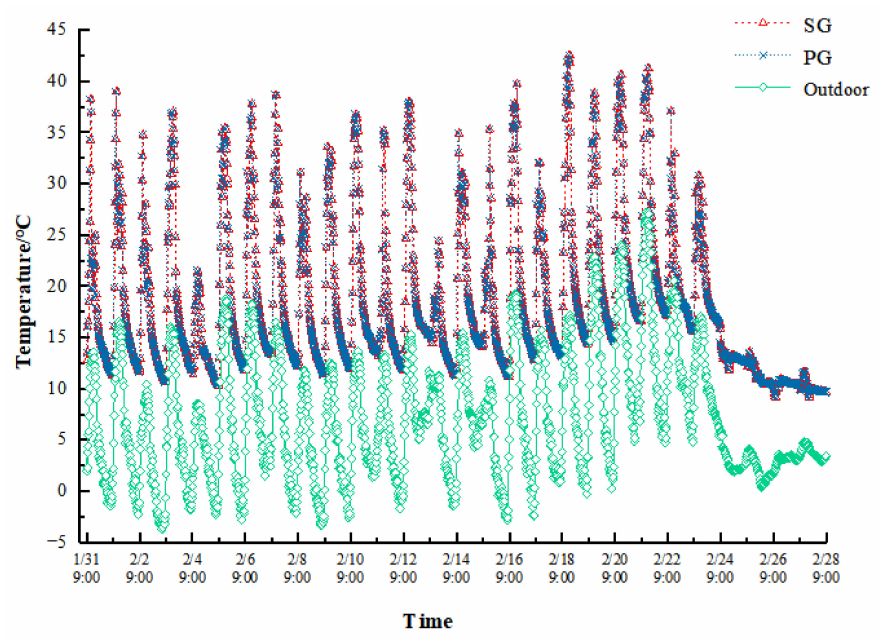
Figure 5. The inside and outside temperature of an active heat storage type solar greenhouse (31 January 2021 9:00–28 February 2021 9:00).